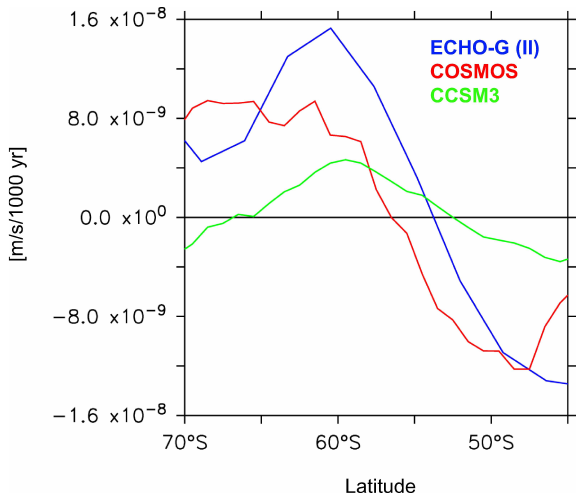
Fig. 8. Zonally averaged annual-mean trends in the Southern Ocean upwelling (based on ocean vertical velocity at 30m depth) for ECHO-G (II) (blue), COSMOS (red) and CCSM3 (green) for the period 7kyr BP to 250yr BP. Positive trends indicate strengthening of